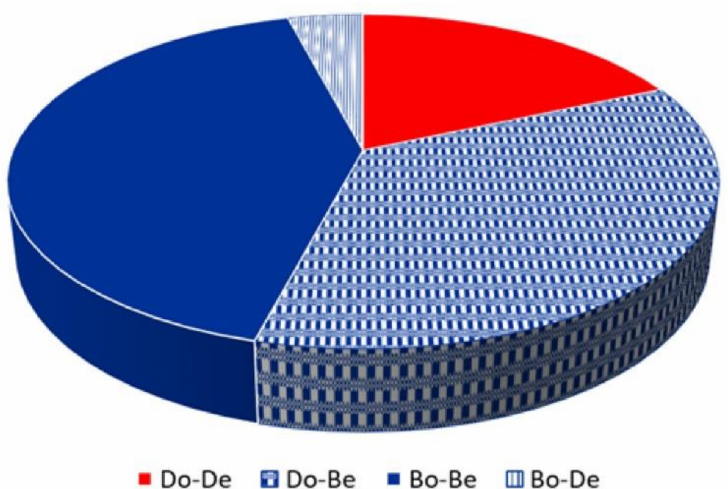
Figure 5. Combinations of coincidences or inconsistencies in the nomenclature of events D and B according to observations and according to re-analysis data.